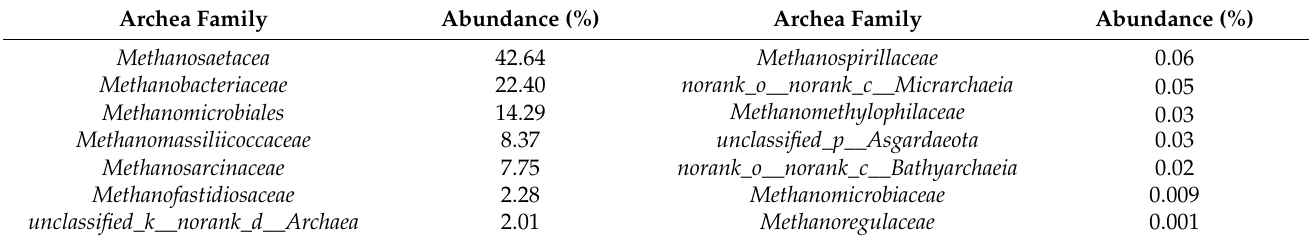
Table 4. The cake layer archaea diversity in the family Level.